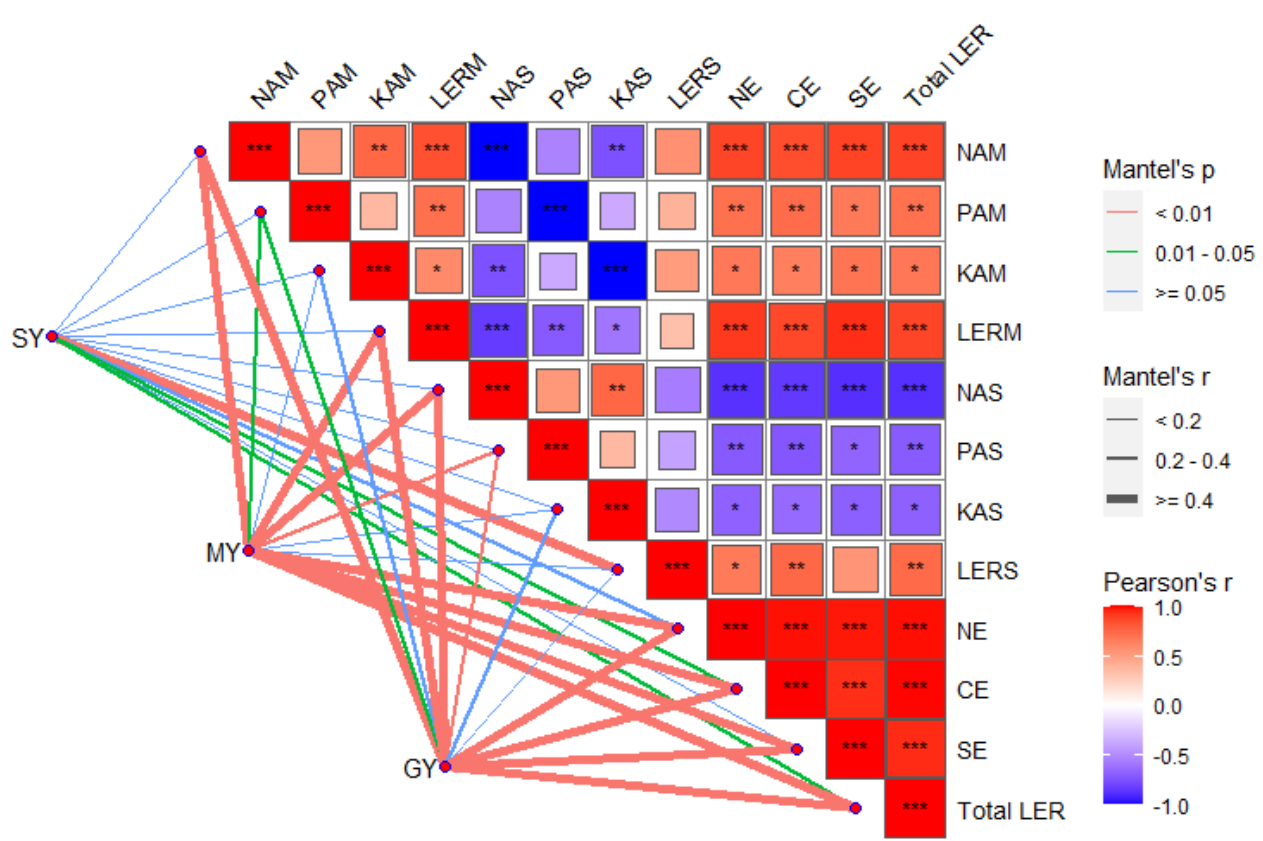
Figure 7. The size and color of the blocks in the figure indicate the strength of the positive and negative correlations among various factors. NA M , PA M , KA M , and LER M represent N, P, and K nutrient aggressivity and partial land equivalent ratio for intercropped maize, respectively. NA S , PA S , KA S , and LER S represent N, P, and K nutrient aggressivity and partial land equivalent ratio for intercropped soybean, respectively. NE, CE, and SE represent net, complementarity, and select effect, respectively. SY, MY, and GY represent intercropped soybean yield, intercropped maize yield, and group yield, respectively. The correlation between crop yield and various factors is indicated by the connecting lines. * p < 0.05, ** p < 0.01, *** p < 0.001.